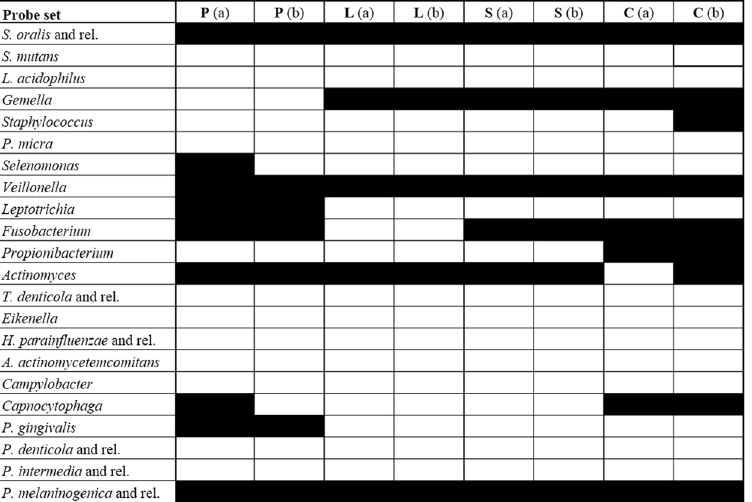
Figure 3. Reproducibility of the OralArray analysis on oral samples. Four samples, representative of four different oral sites (S: saliva, L: lingual plaque, P: supragingival plaque, C: healing cap), were subjected to two separate LDR-UA experiments ( a,b ). Response of each probe set for the presence/absence of the bacterial target is displayed: black: positive response (P < 0.01); white: negative response (P >